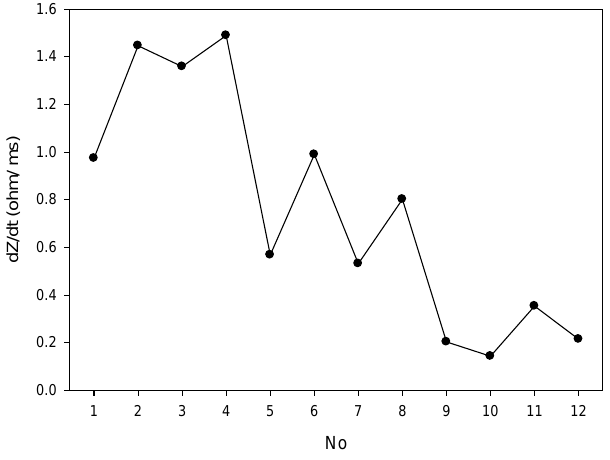
Figure 6. The change of ΔZ/Δt measurement from No. 1 to 12.